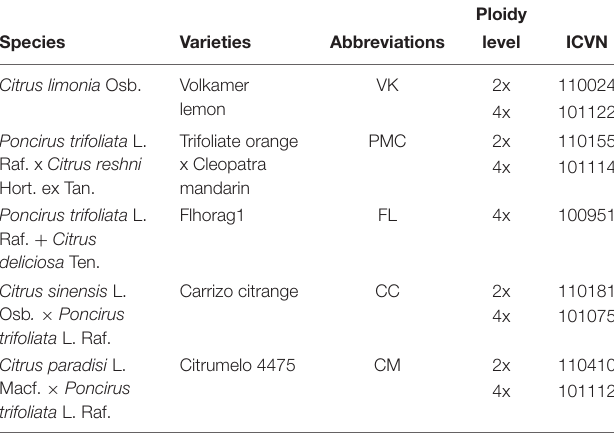
TABLE 1 | Citrus varieties used for physiological and biochemical